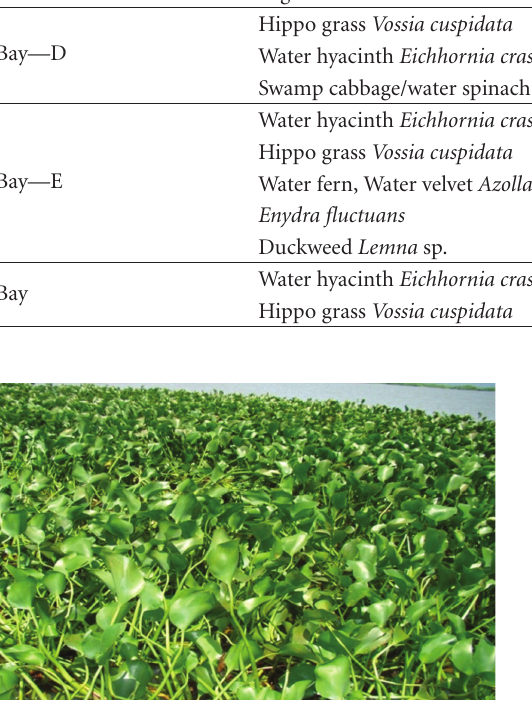
Figure 2: A pure population of the water hyacinth.